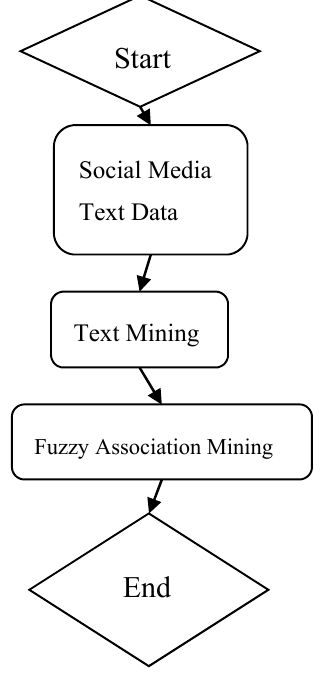
Figure 1. Flowchart of the research process.